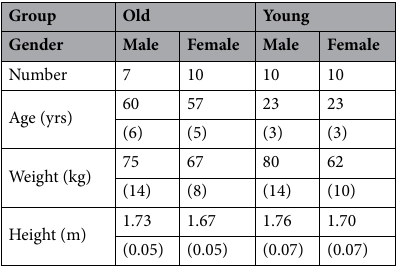
Table 2. Subject information: gender, age, body weight and height; XX (X) stands for Mean